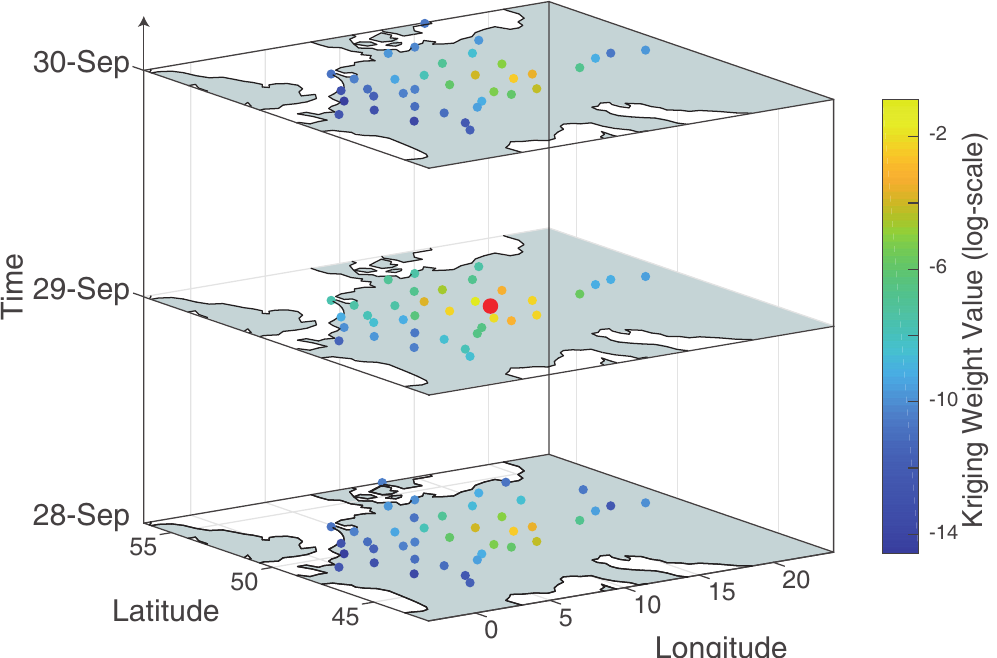
Figure A6. Illustration of the kriging weight values computed for the kriging estimation of M at an unknown location (red dot). Here we illustrate only the neighbors within +/ − 1 day and a spatial extent of 600